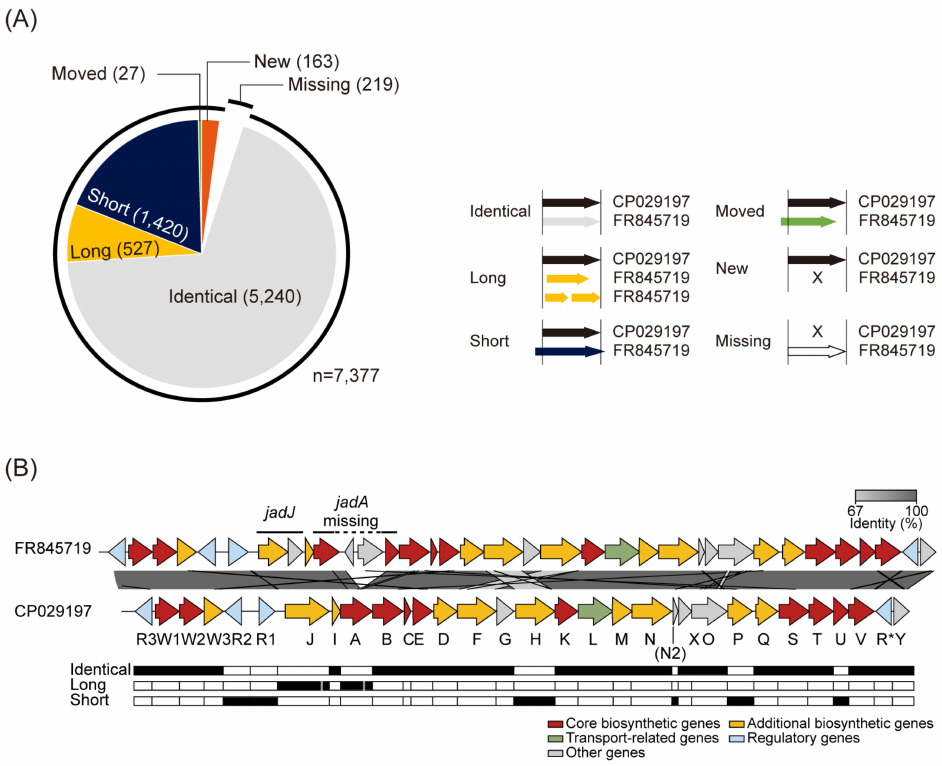
Figure 2. High-quality genome completion of S. venezuelae ATCC 10712. ( A ) Corrected gene annotation ofCP029197comparedtothatofFR845719. TheannotatedgenesofCP029197werecategorizedaccording to the 5 (cid:48) and 3 (cid:48) ends of the genes of FR845719. ( B ) Alignment of jadomycin BGC from the previously reported genome of ATCC 10712 (FR845719) and the newly completed genome (CP029197). The genes were colored according to the antiSMASH prediction. Gray bars between the clusters show the BLASTn identity